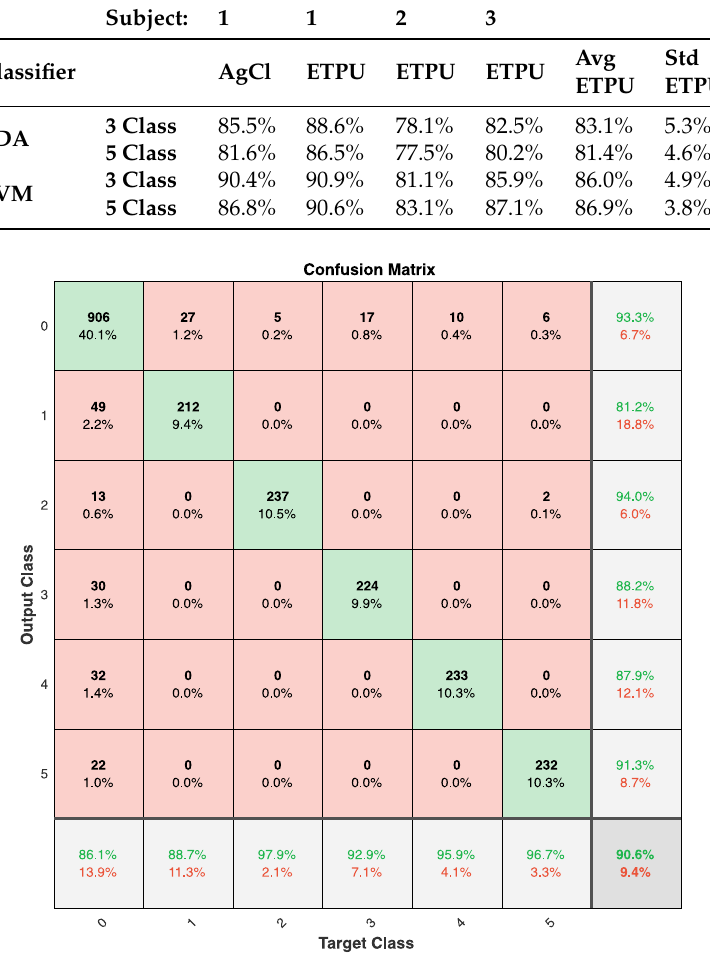
Figure 17. Confusion matrix of subject one SVM classifier for the TPU